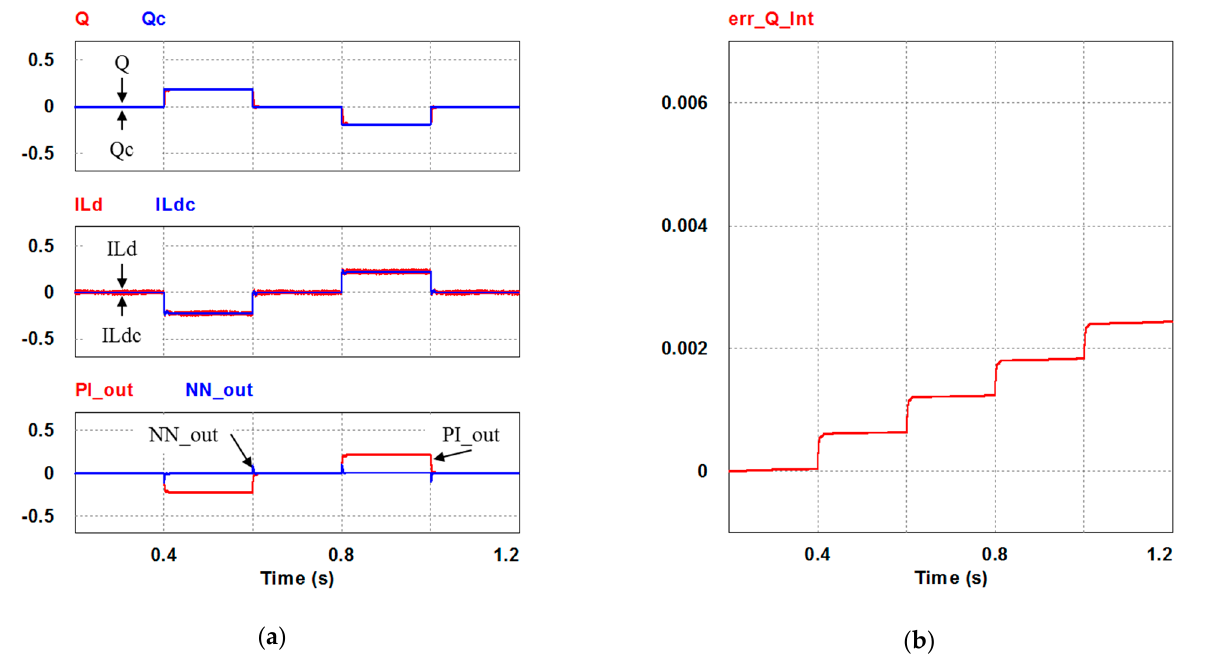
Figure 20. Case 2 simulation result: ( a ) reactive power feedback and its command, inductor current power and its command, and reactive power controller outputs (all control signals are in V); ( b ) accumulated reactive power control error.